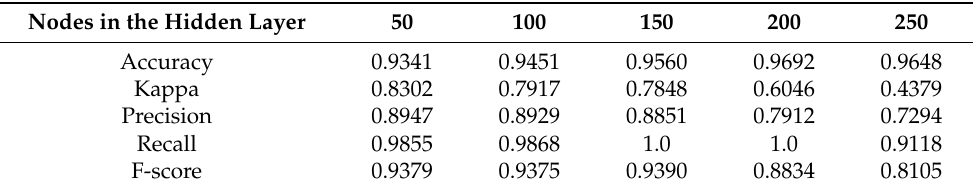
Table 5. Evaluation metrics for extreme learning machine (ELM) with different hidden layer nodes in the standalone environment.